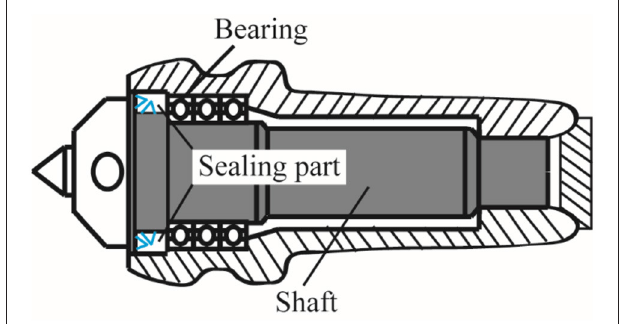
FIGURE 1 | Schematic of the rotation